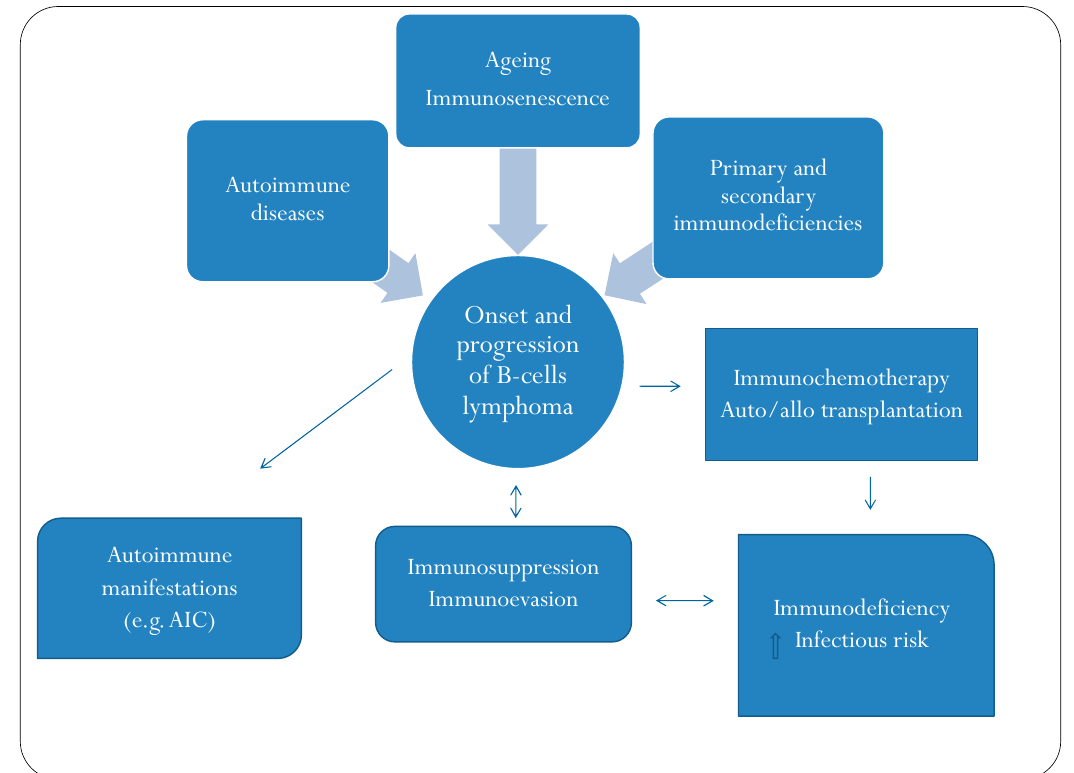
Figure 1. The dynamic relationship between the immune system and B-cell lymphoma: the mutual interactions between the lymphoma and the immune system are active through all stages of the natural history of the disease. AIC: autoimmune cytopenias.